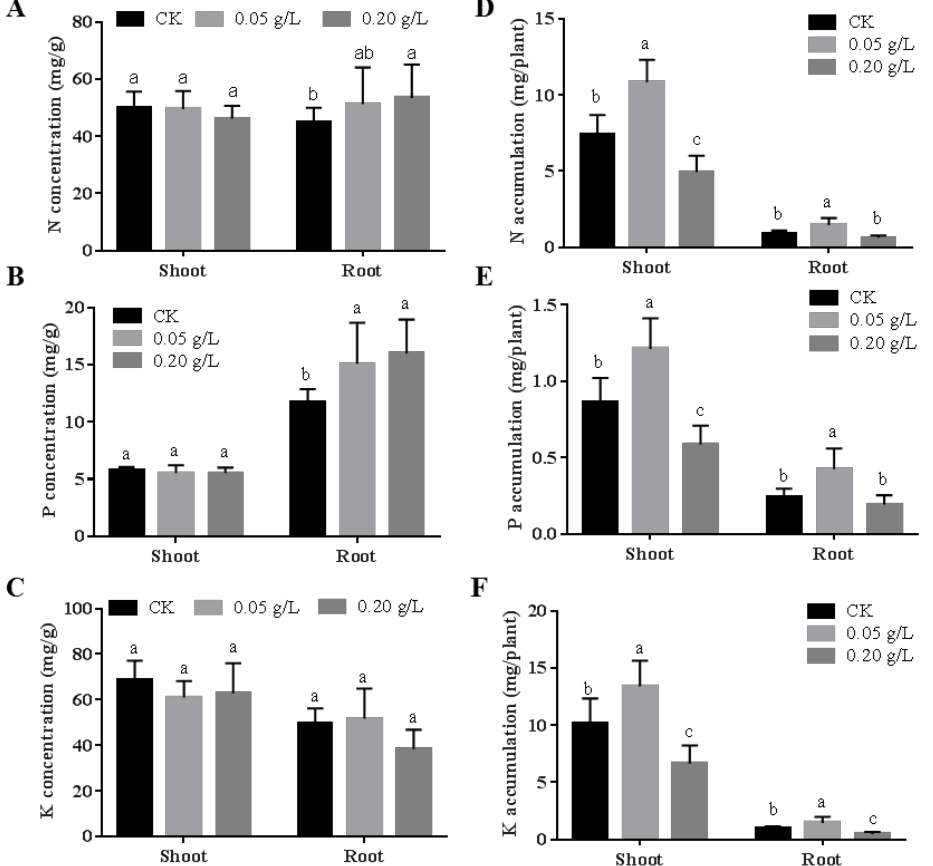
Figure 5. The concentration and content of nitrogen (N), phosphorus (P) and potassium (K) in shoot and root of Brassica napus under different CMS treatments. CK is a full-strength Hoagland’s solution. Two concentrations (0.05 and 0.20 g L −1 ) of CMS were added to the Hoagland’s solution. ( A ) N concentration; ( B ) P accumulation; ( C ) K concentration; ( D ) N accumulation; ( E ) P accumulation; ( F ) K accumulation. Different letters indicate the significant differences at p < 0.05 by Duncan’s test. N = 6.